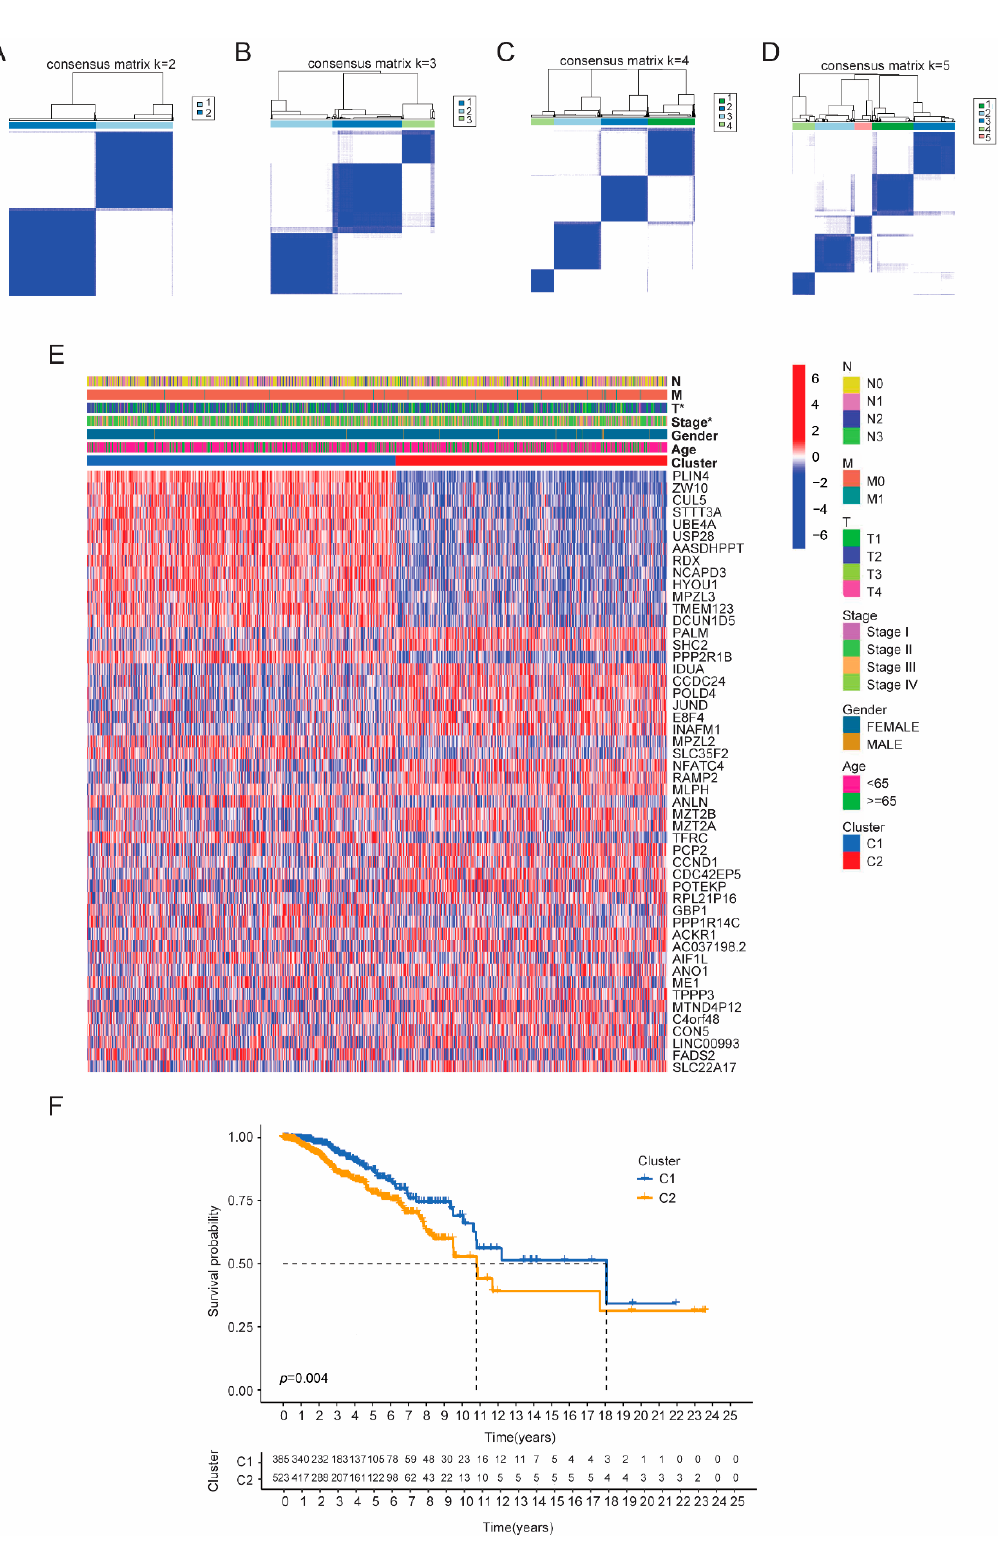
Figure 2. Identification of cancer patients subclusters based on the CRGs. ( A – D ) A total of 1109 BRCA patients were grouped into two clusters according to the consensus clustering matrix (k was set as 2–5). ( E ) Heatmap of the correlation between subclusters and DEGs or the clinicopathologic characters. ( F ) Kaplan–Meier OS curves analysis for cancer patients according to the two clusters.